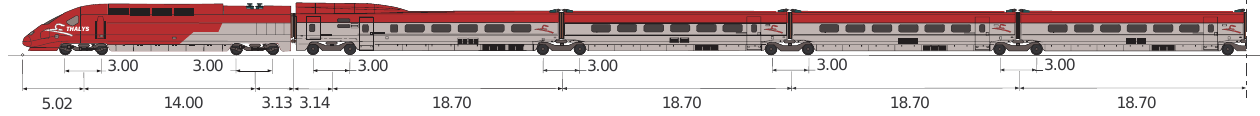
Figure 11. Thalys HST dimensions